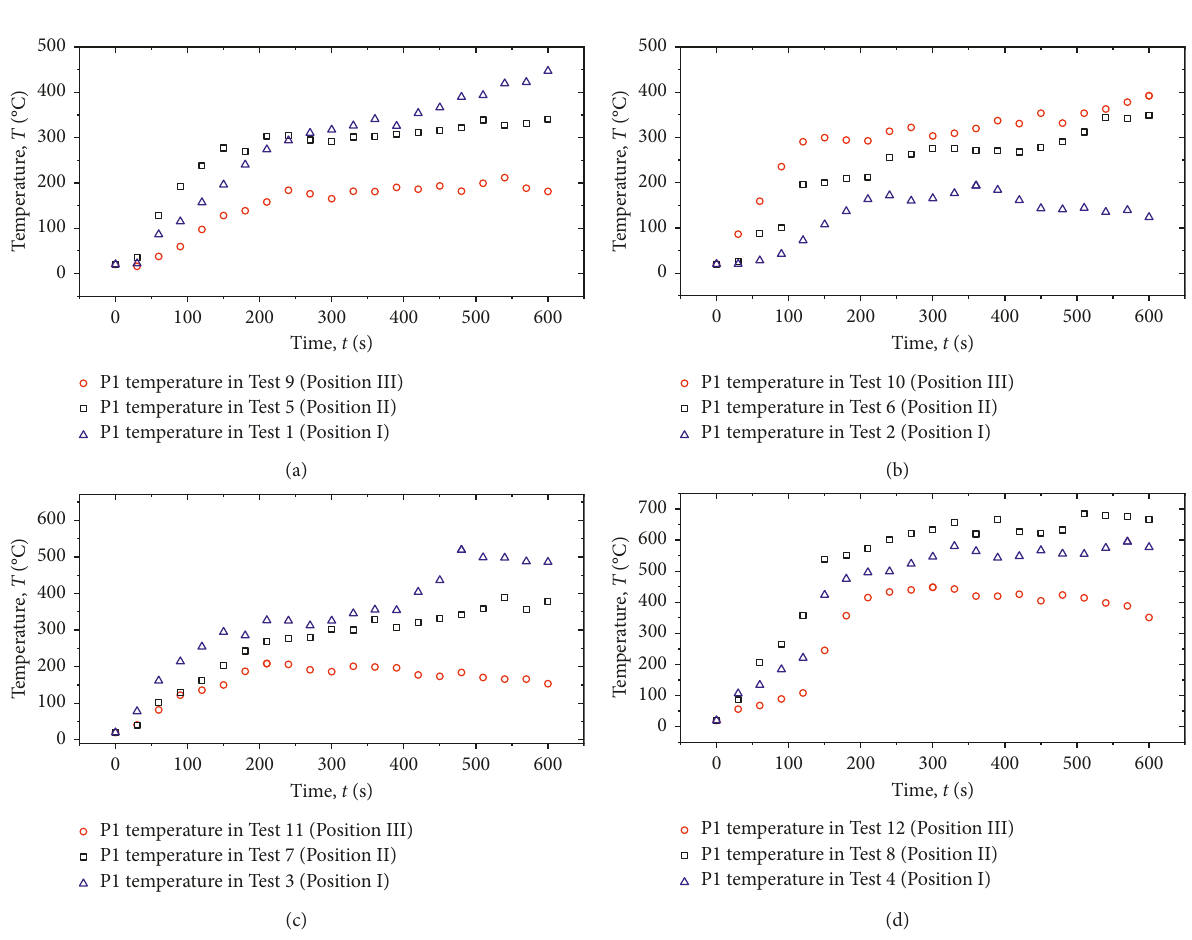
0.7, V 2 0. (c) V 1 (cid:31) (cid:31)